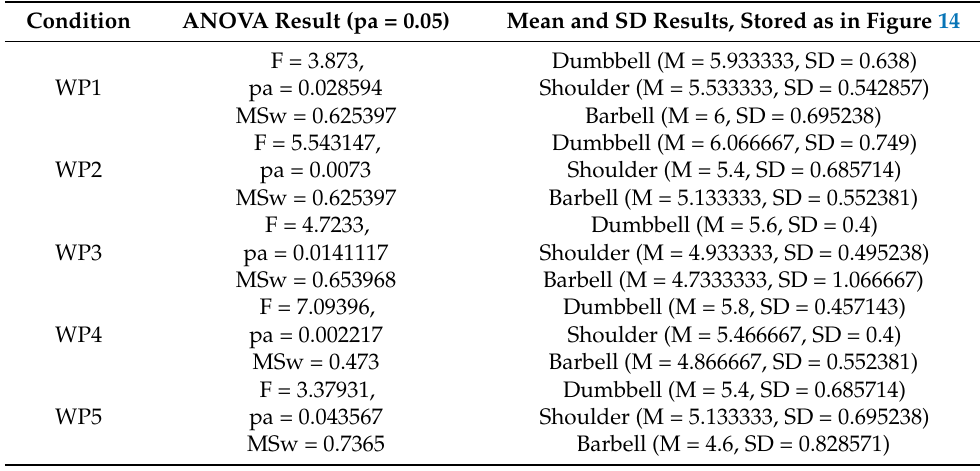
Table 9. Results of the ANOVA test of the weight perception in Experiment